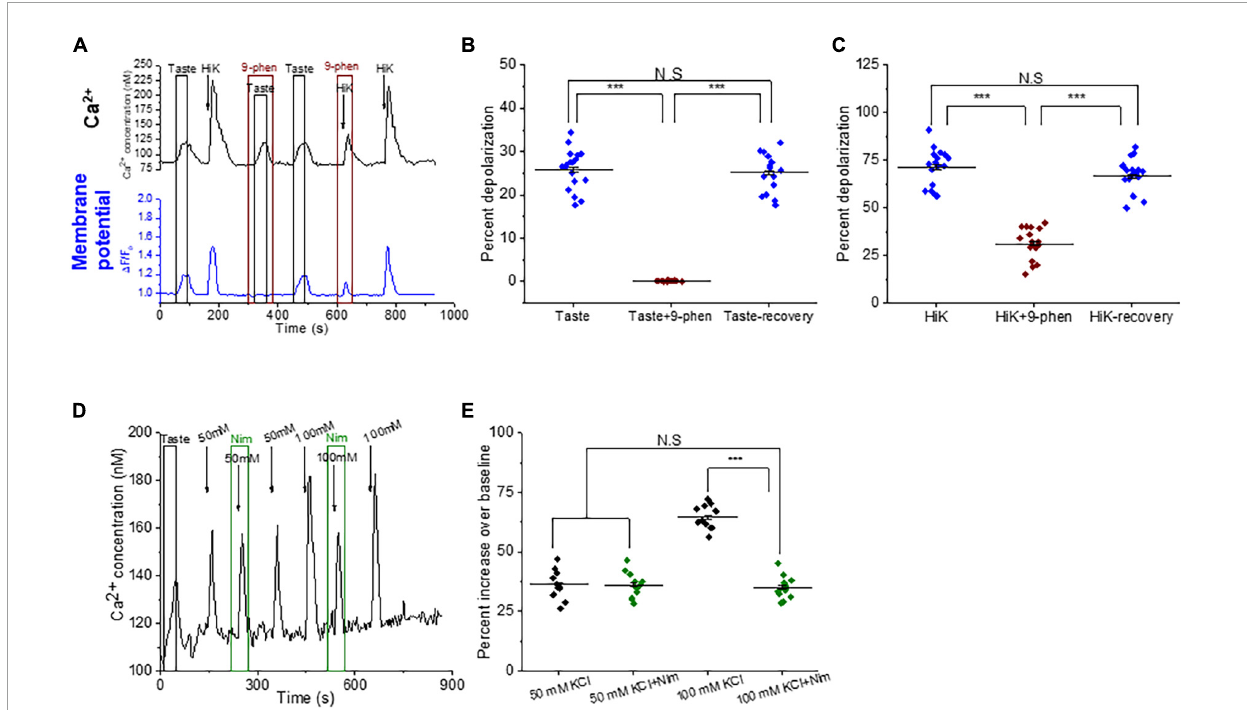
FIGURE6 TRPM4-mediated depolarization is necessary to activate L-type VGCCs in BR cells. (A) Representative dual Ca 2 + (black line) and membrane potential (blue line) imaging traces from BR cells showing simultaneous taste and 50 mM KCl-evoked calcium signals and membrane depolarization. Inhibiting TRPM4 abolished the taste-evoked depolarization ( B , F ( 2 , 51 ) = 299.68, p = 0), while the KCl-induced depolarization was significantly reduced ( C , F ( 2 , 51 ) = 109.90, p = 0, n = 18 cells from 6 mice). (D) A representative calcium imaging trace from the TRPM4-KO mice. (E) In the TRPM4-KO cell, 50 mM KCl generated a small calcium influx that was not inhibited by nimodipine (10 µ M). When 100 mM KCl was applied, the calcium influx signals increased and were then partially inhibited by nimodipine (10 µ M) ( F ( 3 , 40 ) = 77.71, p = 0, n = 11 cells from 4 mice) (*** P < 0.001; N.S = Not